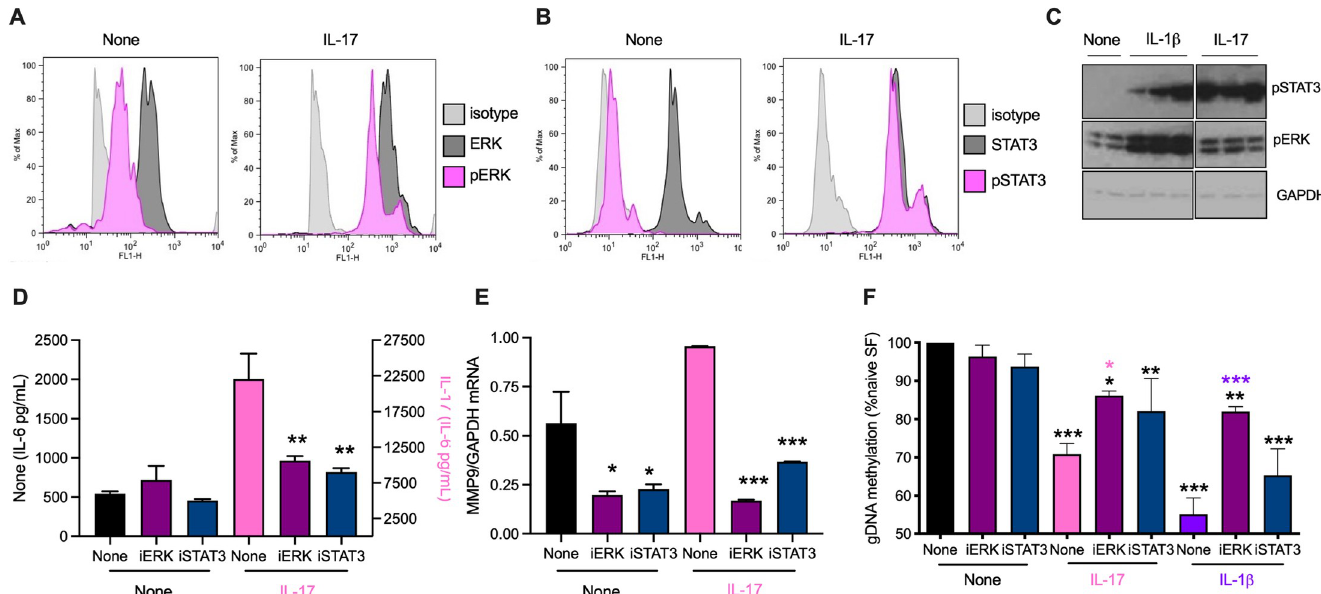
Fig 3. IL-17 and IL-1 β stimulate ERK and STAT3 in SFs. Flow cytometric analysis of ( A ) ERK and ( B ) STAT3 activation, determining the relative expression of dually phosphorylated versus total ERK or phosphorylated STAT3 versus total STAT3 expression, following incubation of Na ï ve-SFs in medium alone or containing IL-17 for 20 min. ( C ) Na ï ve-SFs chronically incubated in medium alone (None) or containing IL-1 β or IL-17 were analysed for pSTAT3, pERK and GAPDH expression by Western blot: individual lanes represent independent SF cultures. The data were quantitated (pSTAT3 or pERK/GAPDH ratios normalized to “None” controls) by ImageJ (Mean ± range, n = 2 for Na ï ve-SFs and Mean ± SEM, n = 3 for CIA- and ES-62-CIA SFs). For pSTAT3: None, 1 ± 0.51; IL-1 β , 11.53 ± 5.06 and IL-17, 22.09 ± 5.14 and pERK: None, 1 ± 0.24; IL-1 β , 2.65 ± 0.29 and IL-17, 1.14 ± 0.13. Na ï ve-SFs, pretreated with iERK or iSTAT3 for two hours, were incubated in medium alone (None) or with IL-17 overnight and levels of IL-6 release ( D ) or MMP9 mRNA ( E ) measured. ( F ) Na ï ve-SFs pretreated with iERK and iSTAT3 for two hours were chronically incubated in medium alone (None) or containing IL-17 or IL-1 β and then their global DNA methylation assessed. Data are mean values ± SEM, n = 3 independent cultures and where � p < 0.05, �� p < 0.01 and ��� p < 0.001 relative to appropriate None control ( D and E ) and None/None control ( F ) and where for iERK, � p < 0.05 (pink) is relative to its IL-17 control and ��� p < 0.001 (purple) is relative to its IL-1 β control ( F ).